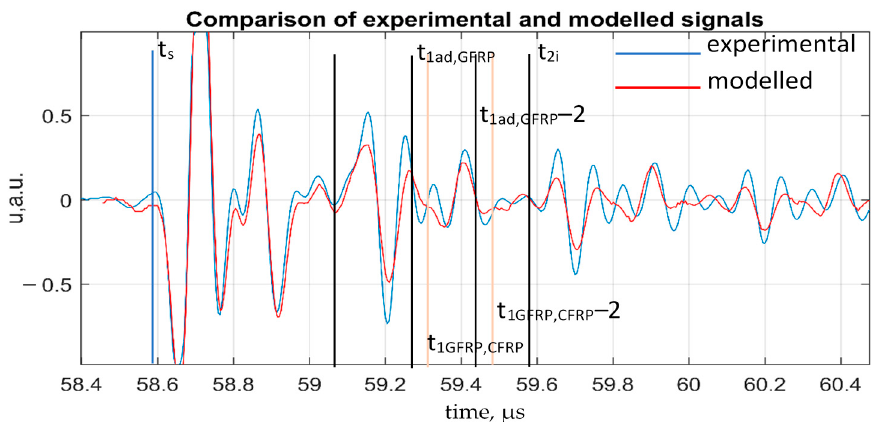
Figure 11. Comparison of modeled and experimental signals received after wave propagation through the component of perfect bonding (t s —time of reflection from the component surface, t 1i —time of reflection from the interface of aluminum and adhesive, t 1ad,GFRP —time of reflection from the interface of adhesive and GFRP, t GFRP,CFRP —time of reflection from GFRP/CFRP, t 2i , t 2ad,GFRP , t 2GFRP,CFRP —corresponding repeated reflections).